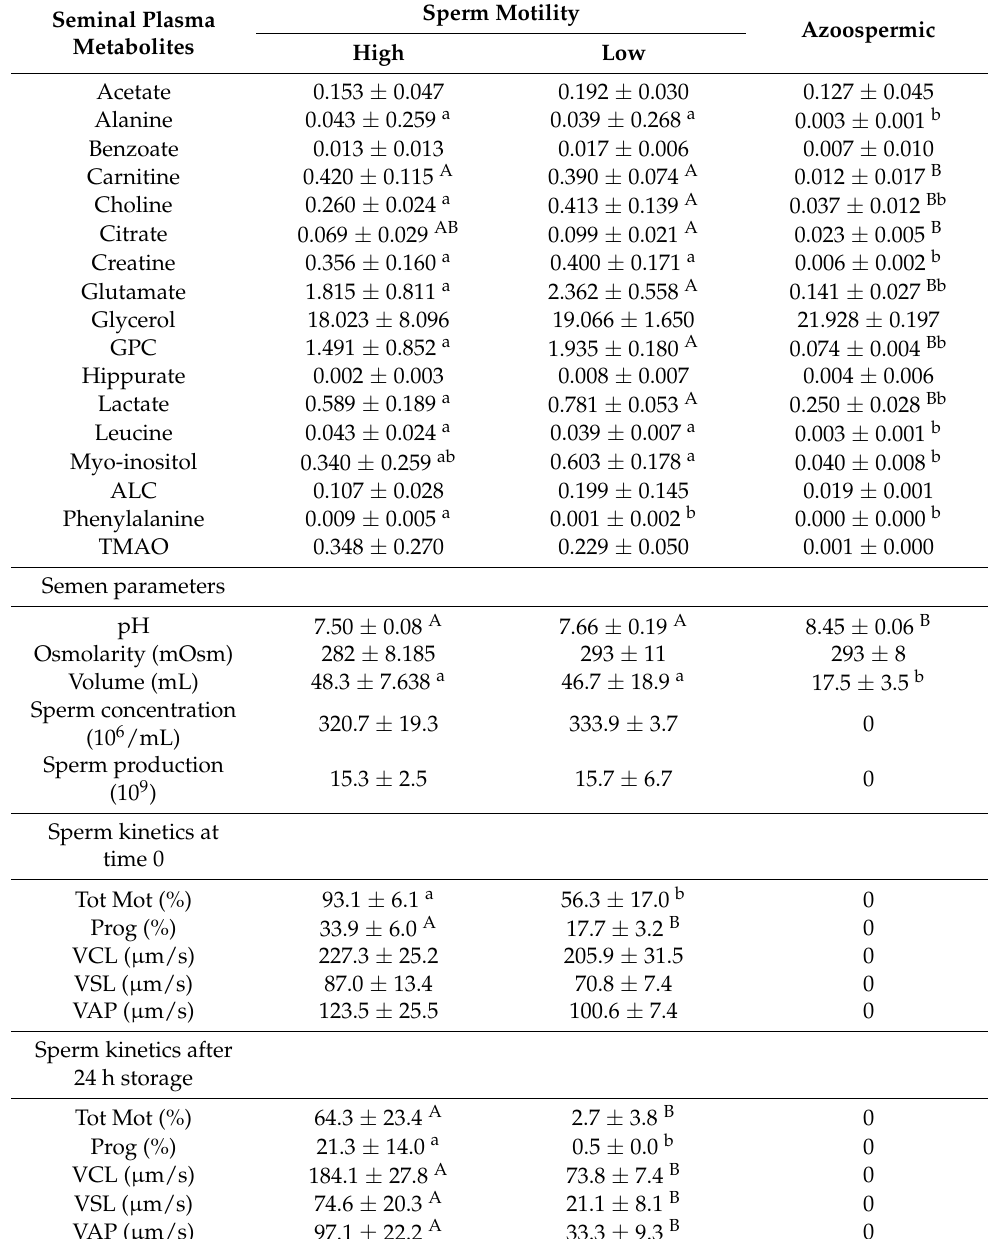
Table 1. Mean ( ± SD) values of seminal plasma metabolites (mM), semen parameters, and sperm kinetics in Martina Franca donkey stallions ( n =